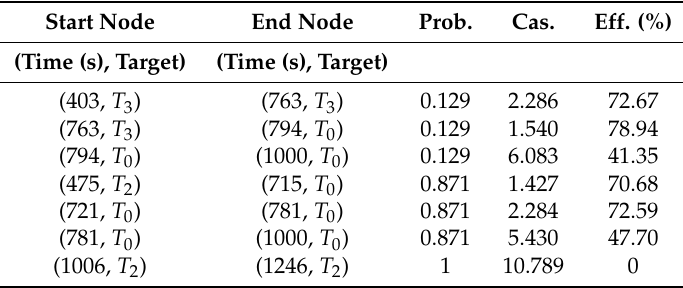
Table 4. Agent-based results associated with the movements of the defender that are part of the optimal patrol strategy.